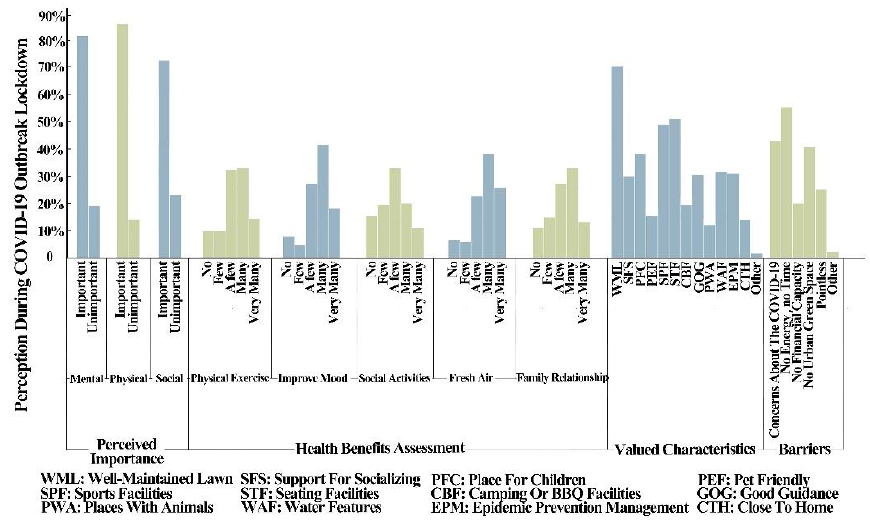
Figure 4. Percentage of perception of the UGSs during the lockdown including importance assessment of UGS’s health benefits, health benefits obtained by visiting the UGSs, valued characteristics for a green experience during the lockdown and barriers to UGS.